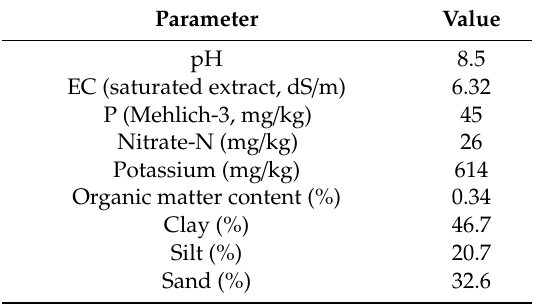
Table 1. Characteristics of the Dalby clay soil used in this